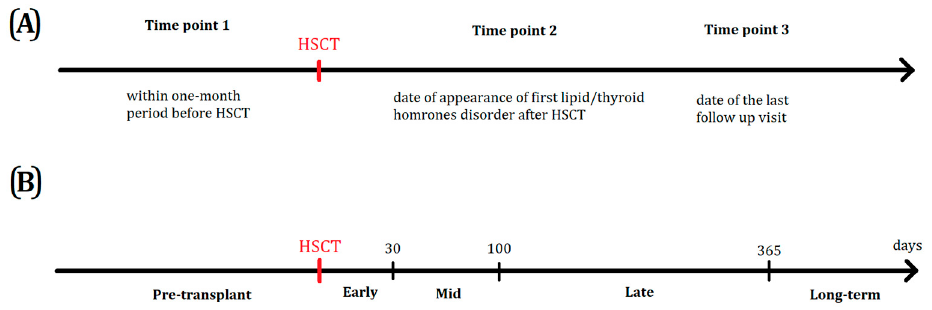
Figure 1. Timelines showing ( A ) the time of lipid and thyroid hormones data gathering due to the expected clinical relevance and ( B ) typical posttransplant periods with respect to graft infusion.